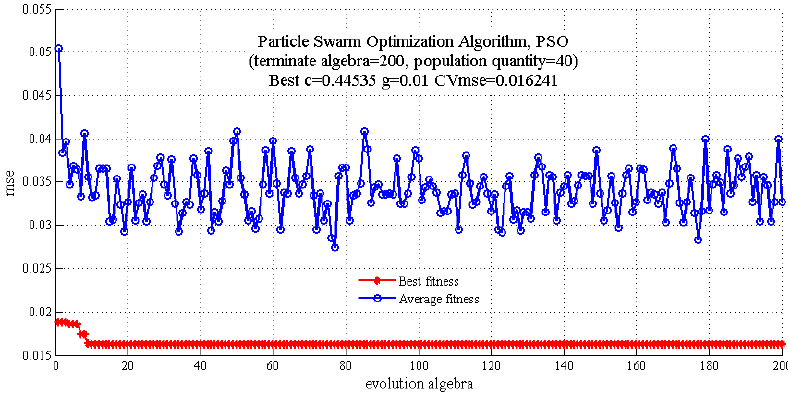
Figure 6. The optimization results for parameters c and g by particle swarm optimization algorithm.